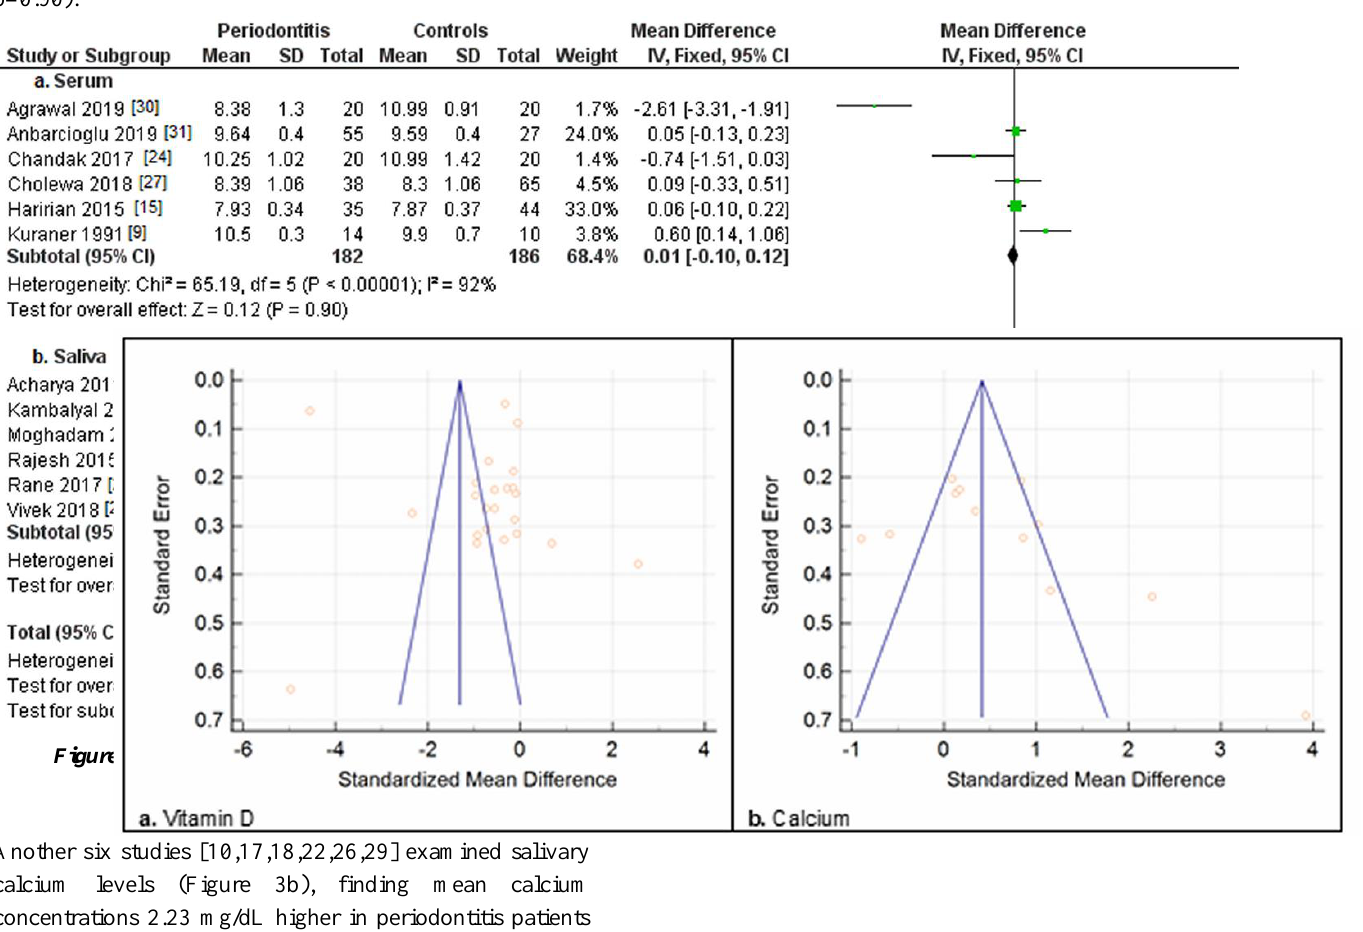
Figure 3: Study data and forest plot graph for serum (a) and salivary (b) calcium levels (mg/dL) in periodontitis patients and controls. Mean±SD: mean±standard deviation.